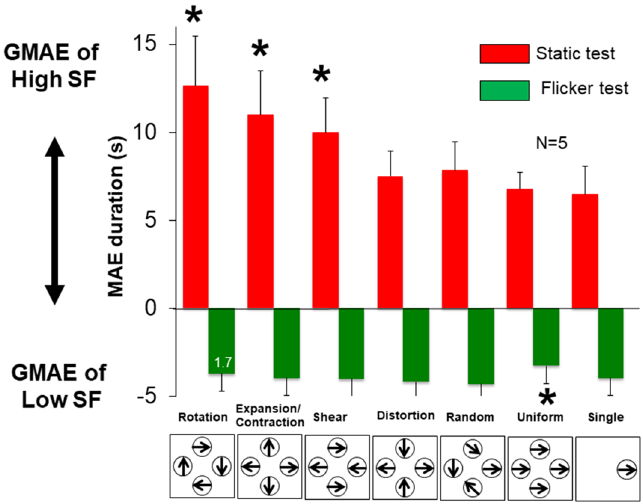
Figure 3. Results for Experiment 1. The MAE duration is plotted for different motion conditions. The MAE from the integration of high spatial frequency components is labeled as positive, and negative values indicate the MAE direction induced by the integration of low spatial frequency components. Asterisks indicate that the MAE duration is statistically significantly different from that of the single condition. In conditions where there were responses opposite to the expected MAE direction, the percentage of time that those occurred is given as a number on the data bar for that condition. This only occurred with the flicker test for the Rotation condition in this experiment.